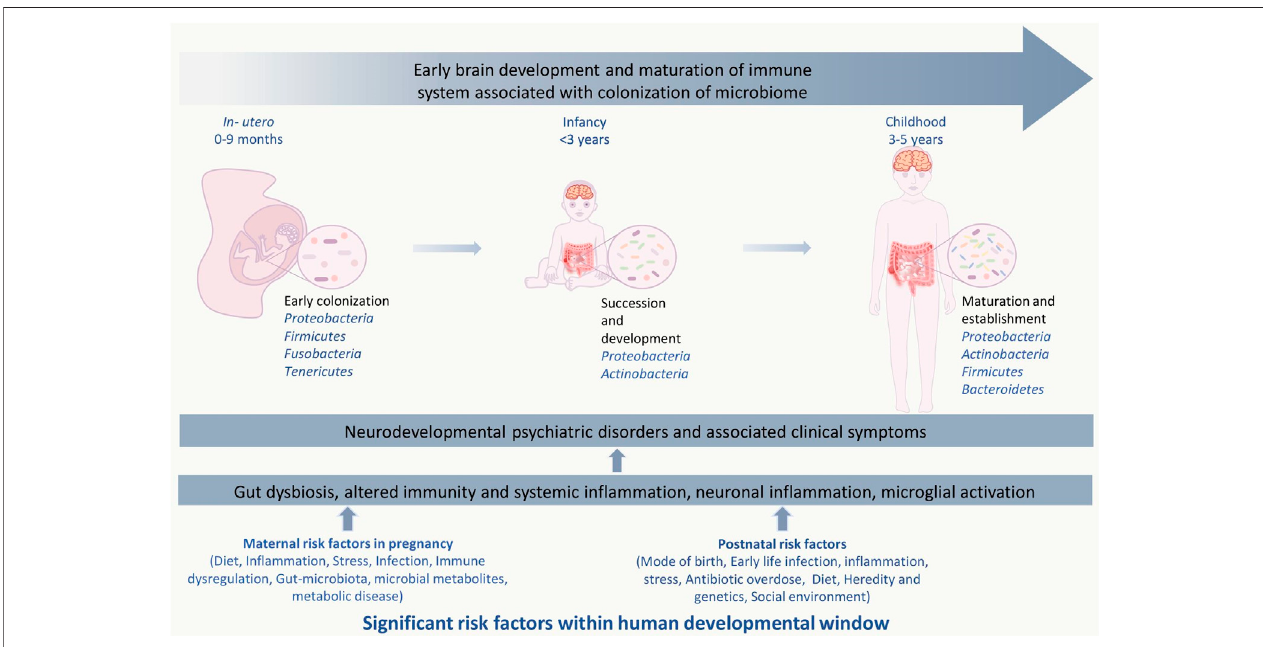
FIGURE 1 | Signi fi cant risk factors affecting events with in human developmental window could bring on neurodevelopmental psychiatric disorders. The critical developmentalwindowspansfromthefetalstageuntilchildhood,whichconsistsofearlycolonizationanddevelopmentofthemicrobiome,developmentofthebrainand nervous system, and development and maturation of the immune system. Within this period, the composition and diversity of the gut microbiome, genetics, maternal, and other reverent factors can alter the overall developmental homeostasis by causing disturbances in the immune system. Gut dysbiosis, immune alteration, and other factors induce microglial activation via in fl ammatory response, which leads to systemic and neuroin fl ammation. This negatively affects the brain development process and leads to abnormal brain development and functionality, including anxiety, depression, intellectual disability, and behavioral abnormality that can be seen in neurodevelopmental and psychotic